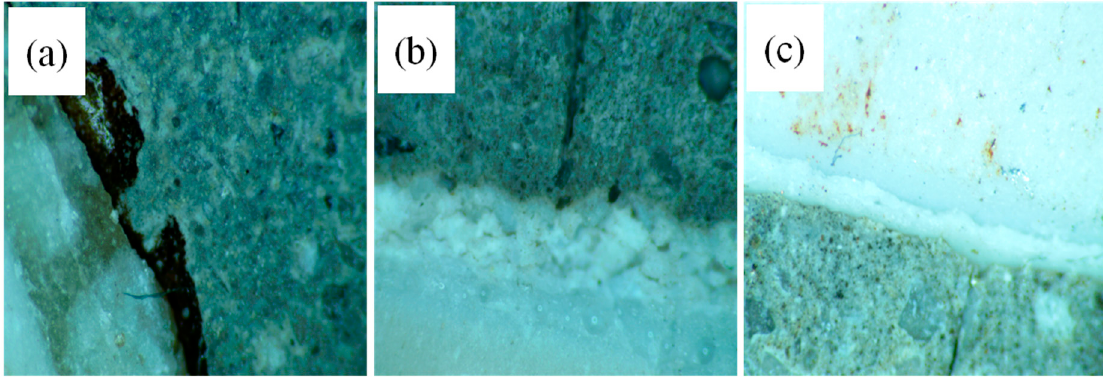
Figure 7. Optical images of porcelain-cement interface of insulators ( a ) 50 years ( b ) 30 years ( c ) 10 years.